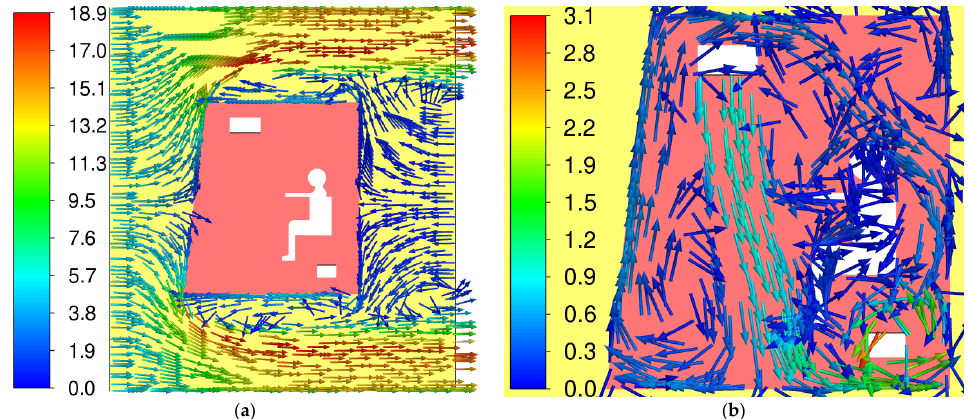
Figure 6. Vector velocity field, m/s: ( a ) in all domains; ( b ) in the cabin (directions and quantitative values of the parameters are shown by arrows in accordance with the color palette).